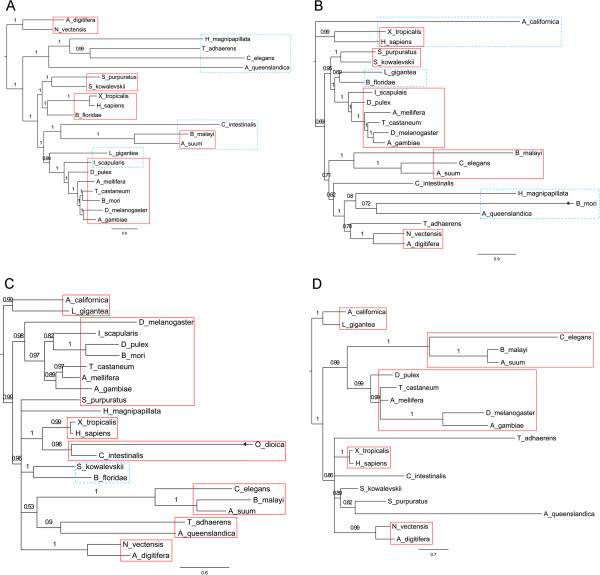
The phylogenetic trees of fat (A), dachsous (B), hippo (C), and yorkie (D). Columns with < =2 amino acids were removed in all datasets. Trees were produced by PhyloBayes (after 2000 generations, maxdiff = 0.01 for fat, 0.036 for dachsous, 0.05 for hippo, and 0.04 for yorkie) based on the substitution model LG + G (gamma category = 4). Trees are shown in scale, except branches with an asterisk. Numbers indicate posterior probability. Red frames mark species correctly grouped; blue frames mark species grouped as in the RAxML trees (Additional file 1: Figure S6).